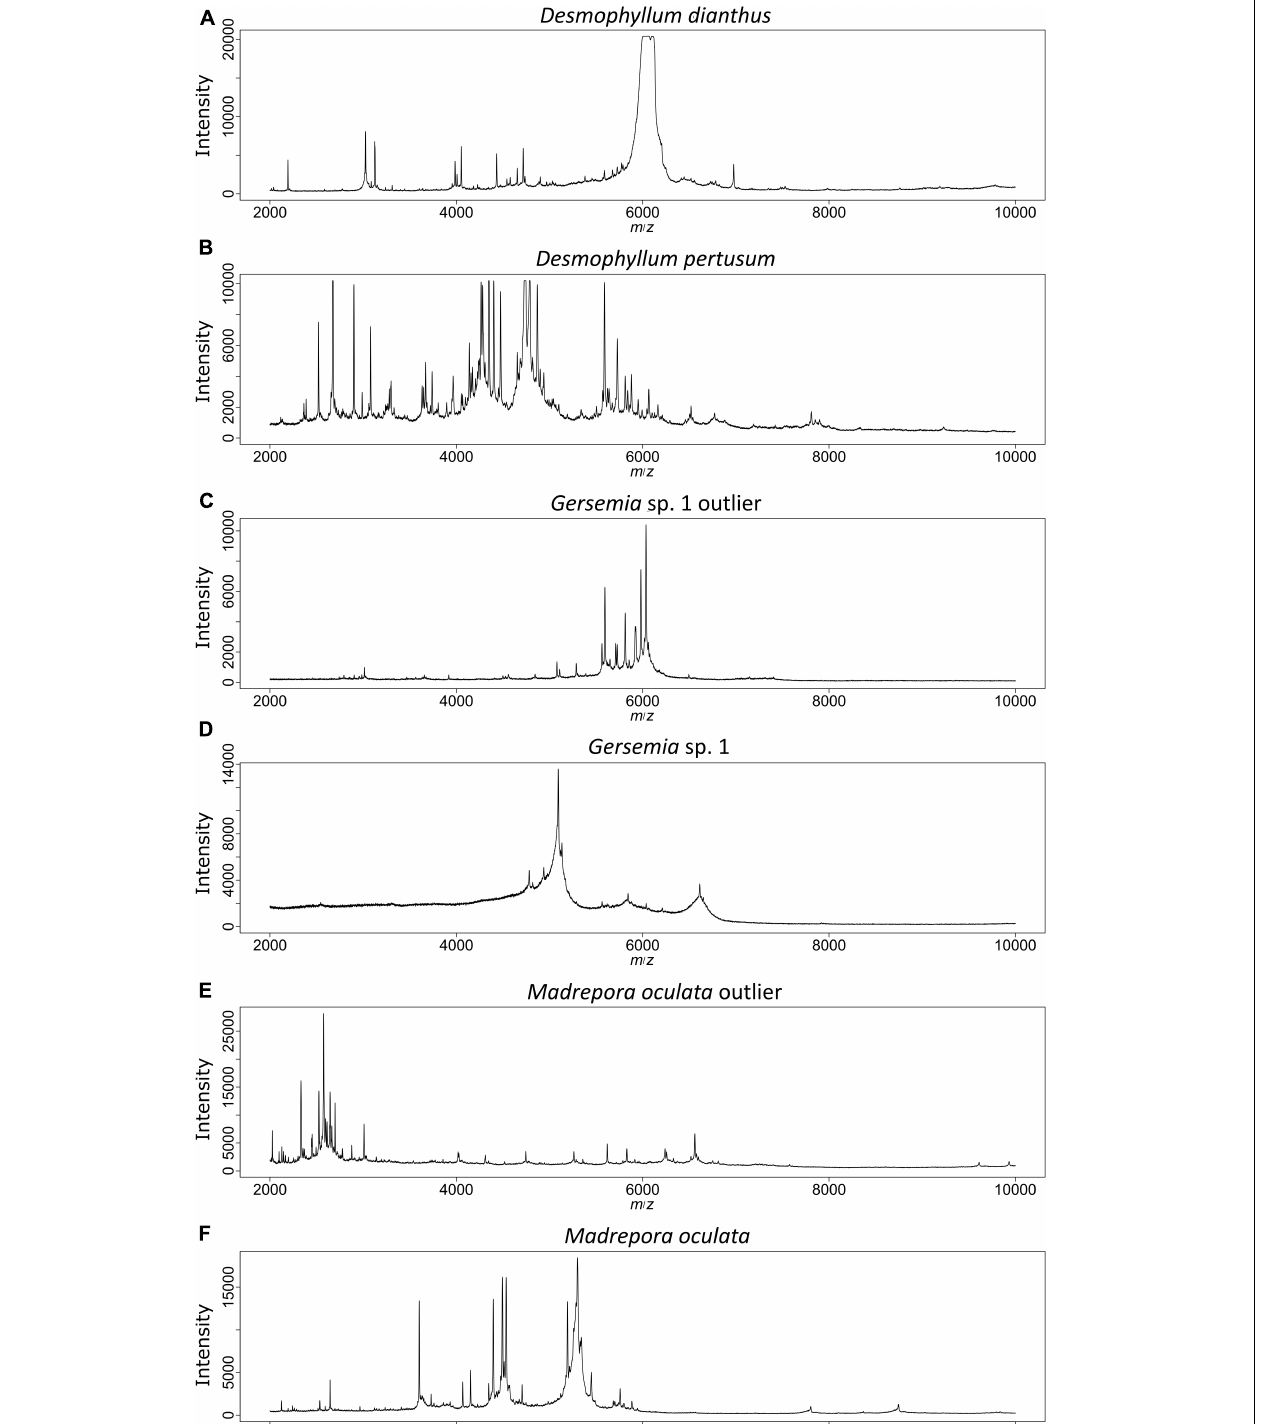
Frontiers in Marine Science |